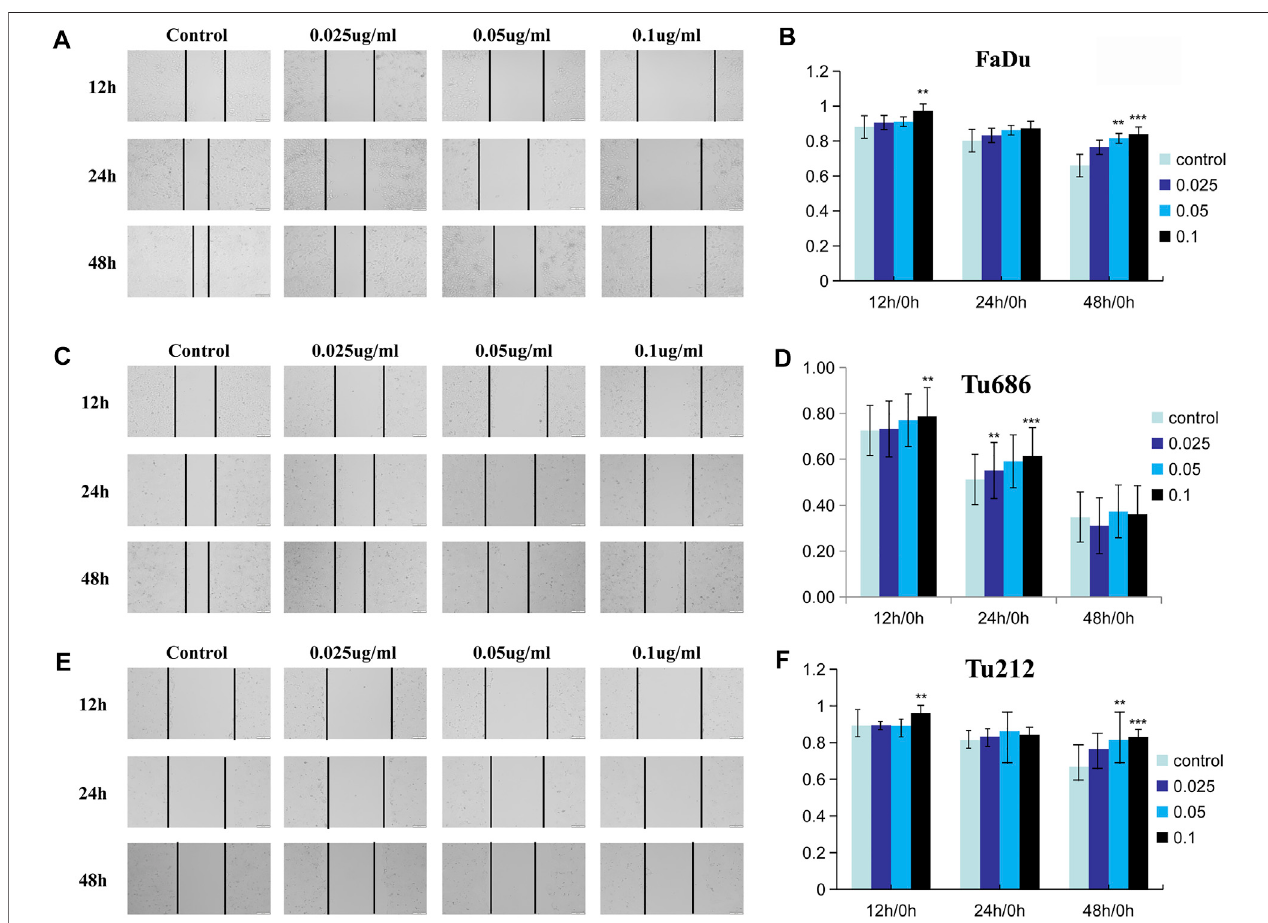
FIGURE4| PSII reduced the motility of human squamous cell carcinoma cell by cell scratch test. (A) PSII inhibited FaDu mobility by the cell scratch test in a dose- and time-dependent manner. (B) The statistical fi gure of FaDu cells scratch test. (C) PSII inhibited Tu686 mobility by the cell scratch test in a dose- and time-dependent manner (D) . The statistical fi gure of Tu686 cells scratch test. (E) PSII inhibited Tu212 mobility by the cell scratch test in a dose- and time- dependent manner (F) . The statistical fi gure of Tu212 cell scratch test. Bars, 50 µm. All the experiments were carried out three times. The bar graphs and the table show quanti fi cation of the results, and each data represent the mean ± SD of three independent experiments (* p < 0.05; ** p < 0.01; *** p < 0.001 vs the control group).